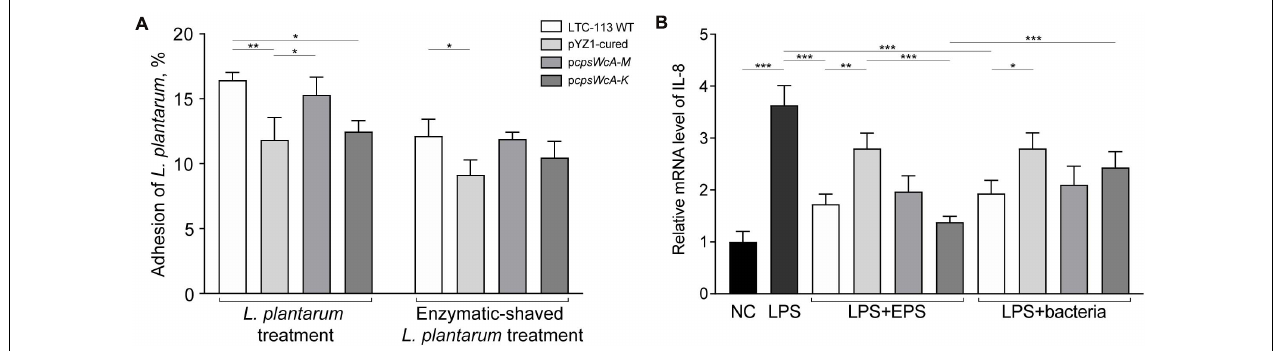
FIGURE 4 | Adhesion of L. plantarum strains to intestine epithelial cells and its inflammation regulation ability. (A) The adhesion abilities of LTC-113 and its derivative strains to Caco-2 cells with or without trypsin shaving. (B) The anti-inflammatory effect by EPS only or bacteria. Values represent mean ± SD of the mean; * P < 0.05; ** P < 0.01; *** P < 0.001.